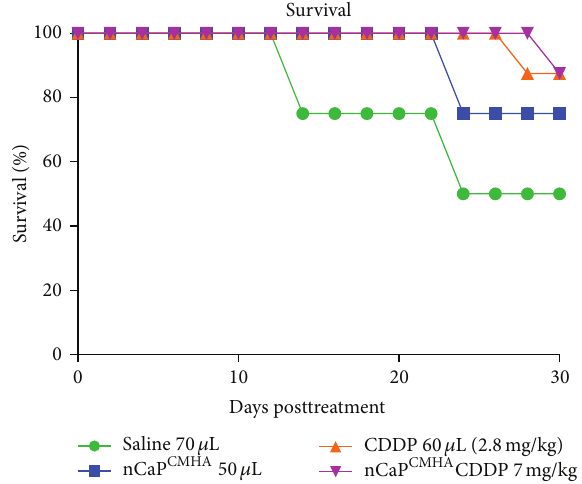
Figure 10: Survival was plotted for the efficacy study shown in Figure 9. The study was conducted on J:Nu mice bearing BT- tumors. Animals were treated once when their tumor 47 4 EMT volume reached 100 ± 10 mm 3 and compared to 2.8 mg/kg CDDP administered near tumor (NT). Tumor volume, grooming, and weight loss were monitored every other day following treatment. Survival was defined as a tumor diameter > 2 cm or inability to groom. A treatment of 7mg/kg nCaP CMHA CDDP and 2.8 mg/kg CDDP (NT) was most effective at prolonging survival compared to control treatments of saline or nCaP CMHA